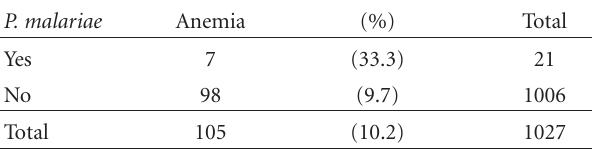
Figure 2: Picture of agarose gel with PCR products . This gel shows a P. vivax diagnosis confirmation by nested PCR method using primer sequences designed from MSP-5/6 conserved blocks in subject 5 (And´eranboukane 125). Table 6: Association between malaria and